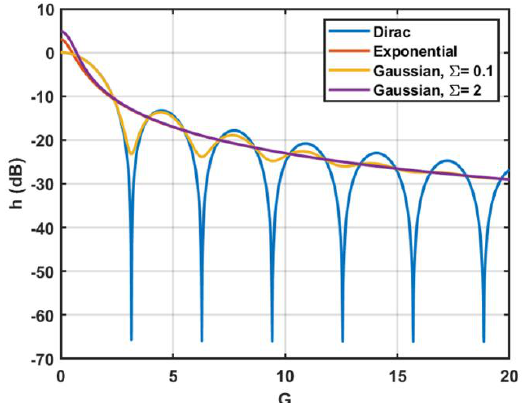
Figure 3. The h function vs. the parameter G for three distributions.